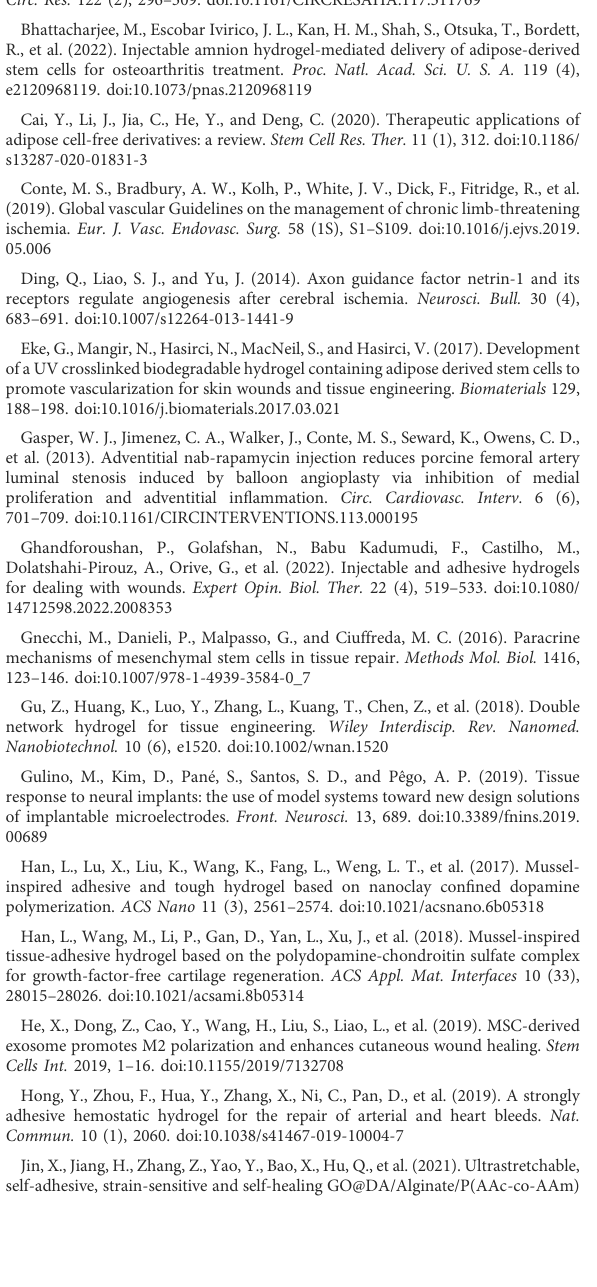
SUPPLEMENTARY FIGURE S1 Difference in water solubility of GO and rGO/PDA. SUPPLEMENTARY FIGURE S2 Characterization of Raw264.7 cells. (A) Immuno fl uorescence of CD68. (B) Flow cytometry of CD68. SUPPLEMENTARY FIGURE S3 Surgical operation and development of the rat model. (A) The N-ADSC- loaded adhesive DN hydrogel was successfully wrapped around the